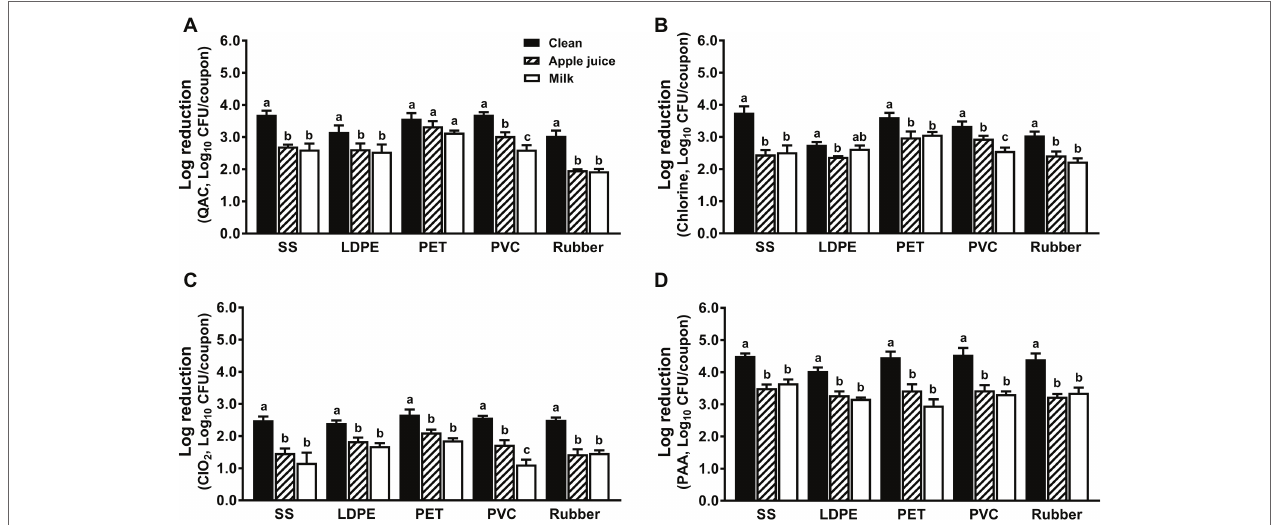
FIGURE 5 | Efficacy of four commonly used sanitizers against L. monocytogenes biofilms on food-contact surfaces conditioned with organic matters. (A) Quaternary ammonium compound (QAC, 400 ppm); (B) chlorine (200 ppm); (C) chlorine dioxide (ClO 2 , 5.0 ppm); (D) peroxyacetic acid (PAA, 200 ppm); stainless steel (SS); low-density polyethylene (LDPE); polyester (PET); polyvinyl chloride (PVC). Apple juice: food-contact surfaces were conditioned with apple juice; milk: food-contact surfaces were conditioned with milk. The 7-day-old biofilms on different surface coupons (15 mm × 7.5 mm) were treated with the respective sanitizers for 5 min, then survivors were enumerated and shown as means ± SEMs, n = 3. a–c Bars topped with the different letters are not significantly different at p ≤